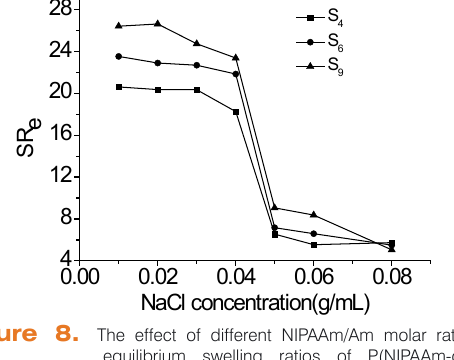
Figure 7. The effect of different cross-linker contents on the Figure 8. The effect of different NIPAAm/Am molar ratios on equilibrium swelling ratio of PNIPAAm hydrogels equilibrium swelling ratios of P(NIPAAm-co-Am) hydrogels at 25 o C in the NaCl solution.